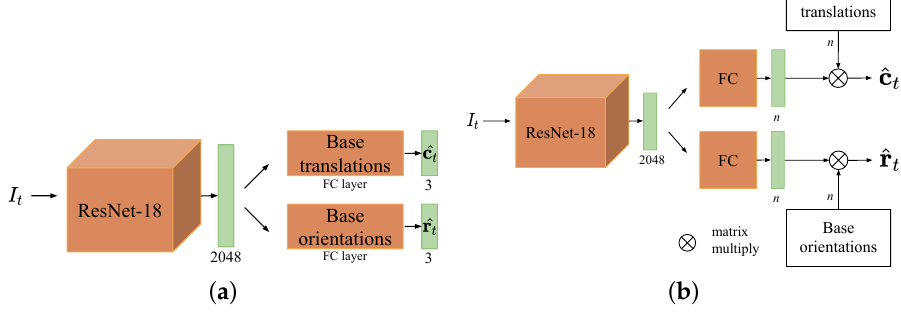
Figure 6. Two network architecture types for a single stream. ( a ) Single-stream with learning-based base poses; ( b ) single-stream with handcrafted base poses.